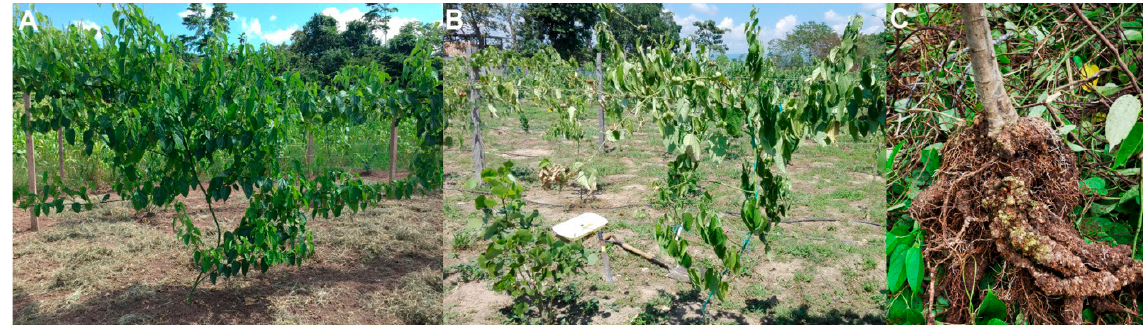
Fig. 1: Plukenetia volubilis plantation in San Martin (Perú), A) Healthy inka nut plant; B) Plant infected with nematodes and Fusarium spp. with yellowing and wilting symptoms; C) Nematode- Fusarium complex in the radicular system of the inka nut.